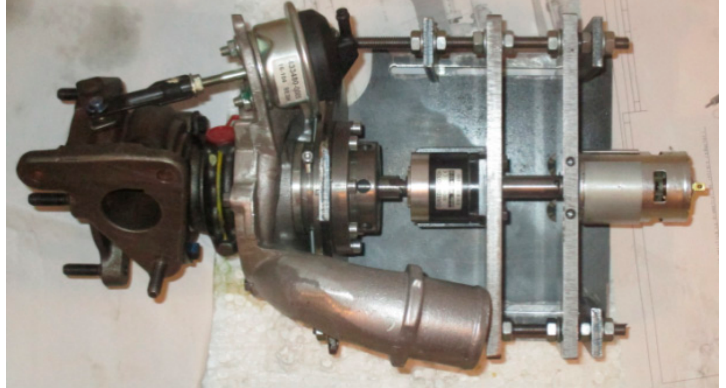
Figure 3. Real construction of the hybrid turbocharger.